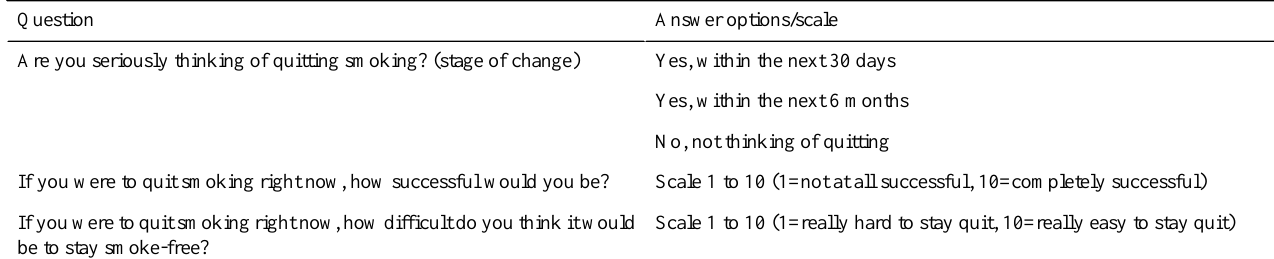
Table 2. Measurements assessing attitudes toward quitting.